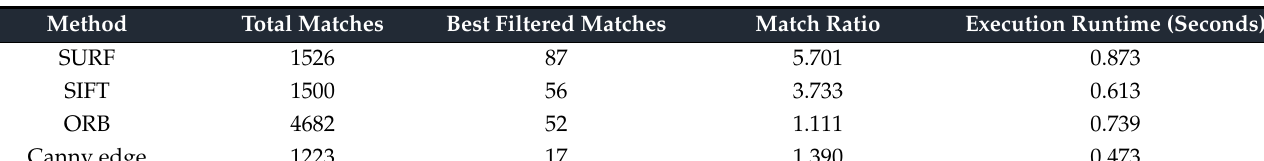
Table 3. Quantitative comparison and computational costs of the different feature detector descriptors (Ahuna Mons vs. Crater B).